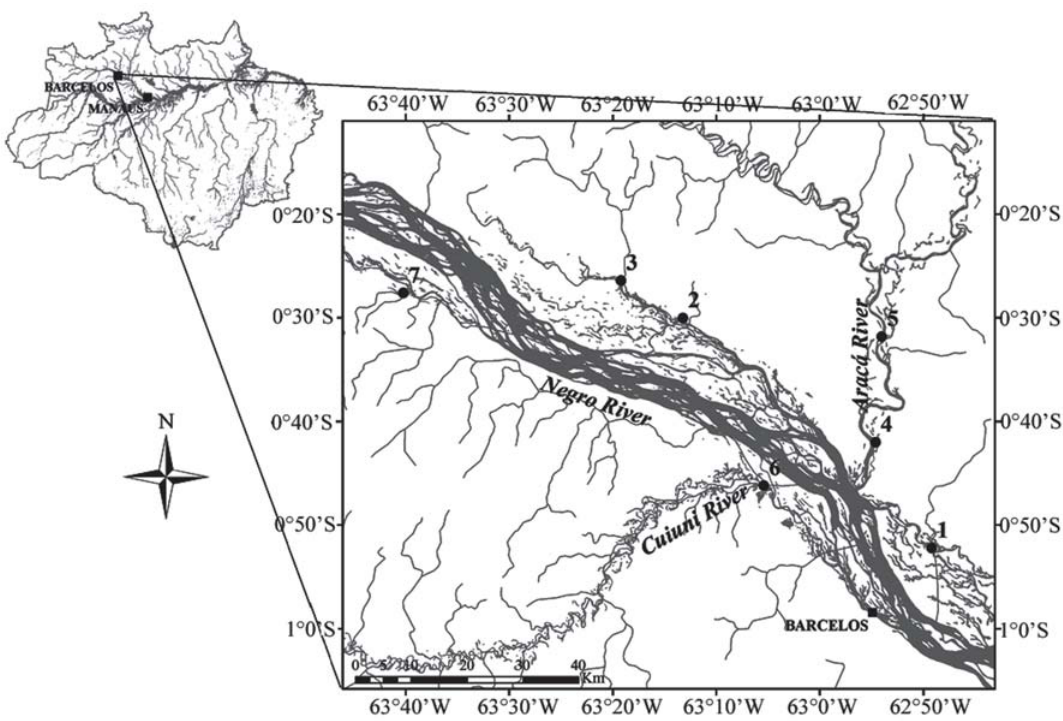
Fig. 1. Sampling locations of specimens of Potamotrygon motoro in the middle Negro River, Barcelos Municipality, Amazonas State, Brazil. 1, Arirahá River; 2, Cuiuni River; 3, Daraquá Stream; 4, Demeni River; 5, Itu River; 6, Maqui Lake; 7, Zamula